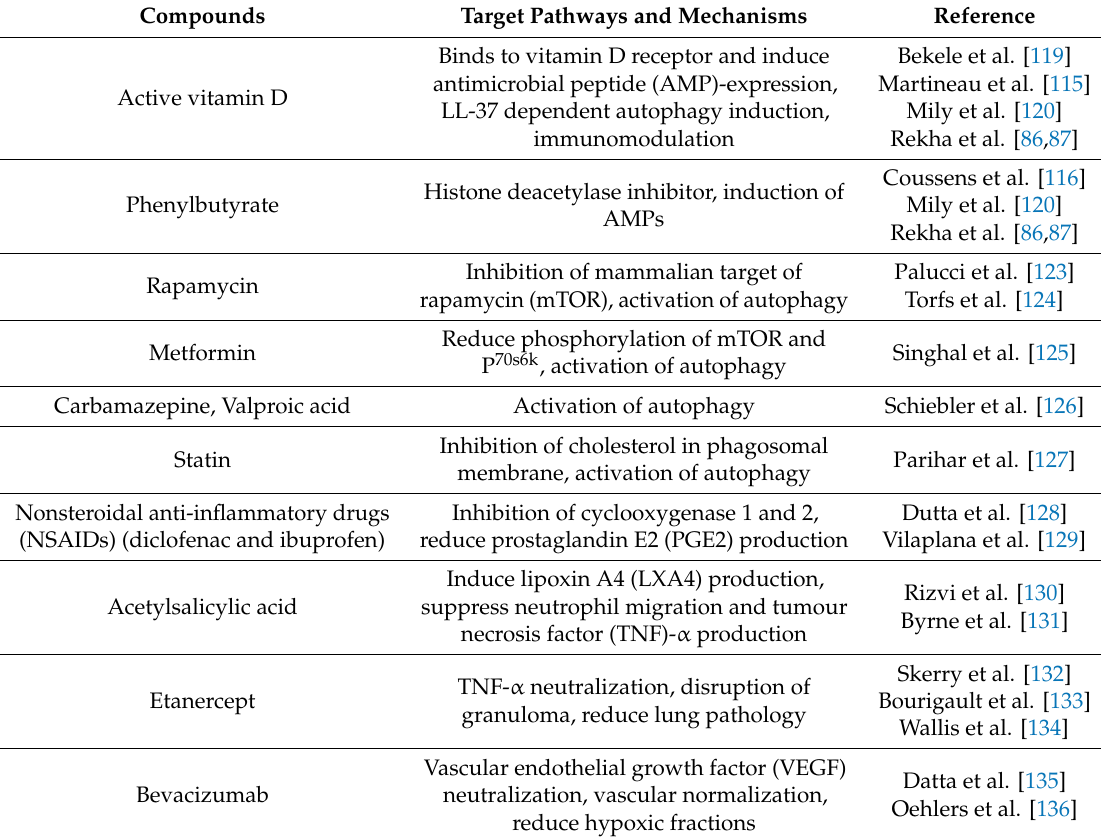
Table 1. HDT related compounds and their host target pathways related to